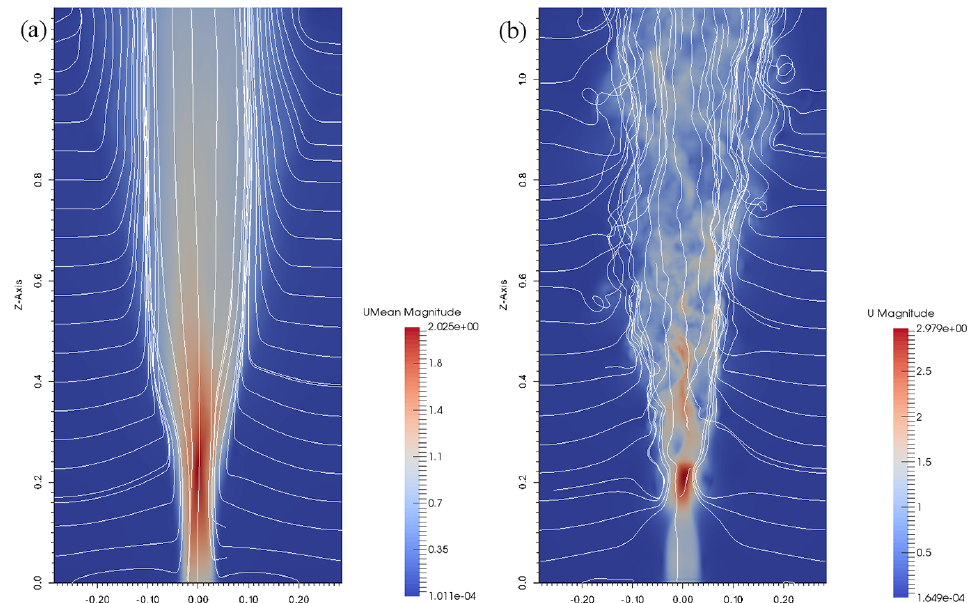
Figure 10. Two-dimensional slice and streamlines of the velocity field: (a) time-averaged velocity field; (b) instantaneous velocity field at t = 10s. The mean velocity field outside the plume is approximatively horizontal while in the plume it is approximately vertical. The region where the mean velocity field change direction is the region where the entrainment of air by the plume occurs.